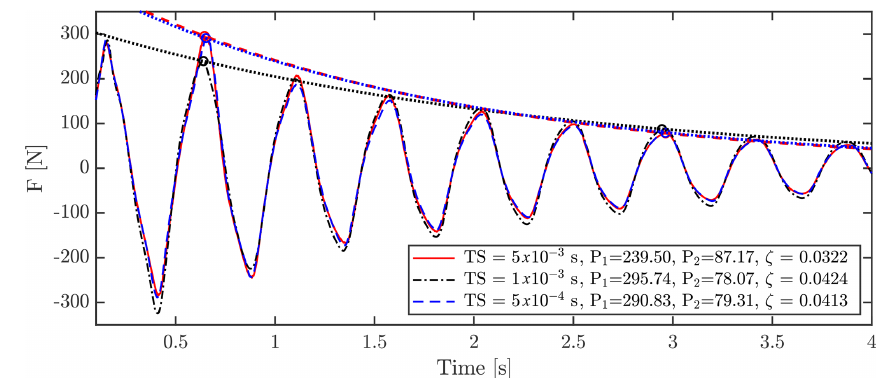
Figure A3. Sum of aerodynamic forces on the blade during vibration using time steps of 5 × 10 − 3 , 1 × 10 − 3 and 5 × 10 − 4